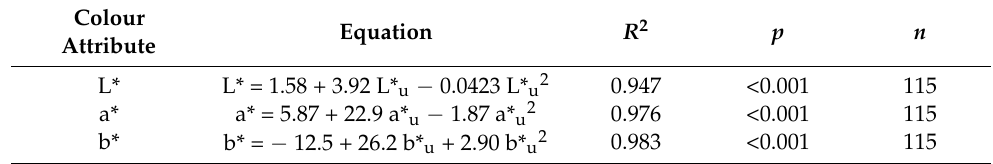
Table 1. Quadratic equations used to calibrate the uncalibrated colourimeter’s L* (L* u ), a* (a* u ) and